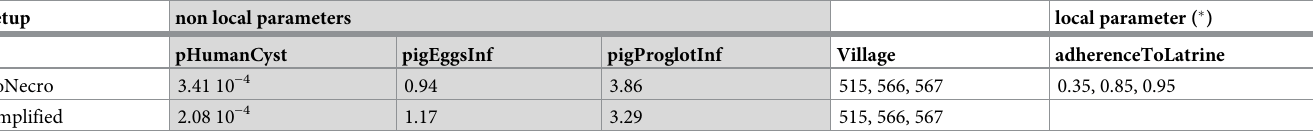
Village adherenceToLatrine